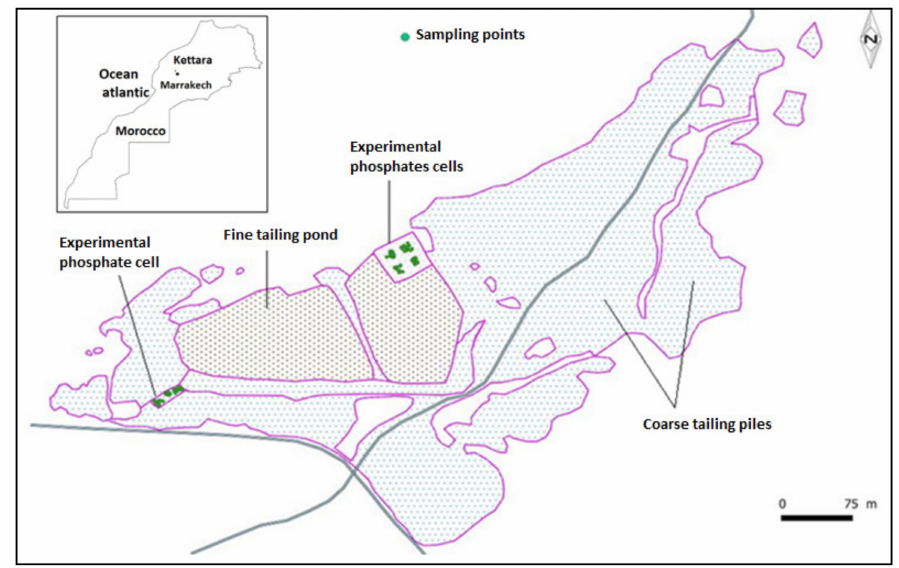
Figure 3. Geographical location of Kettara mine site and location of sampling area on experimental